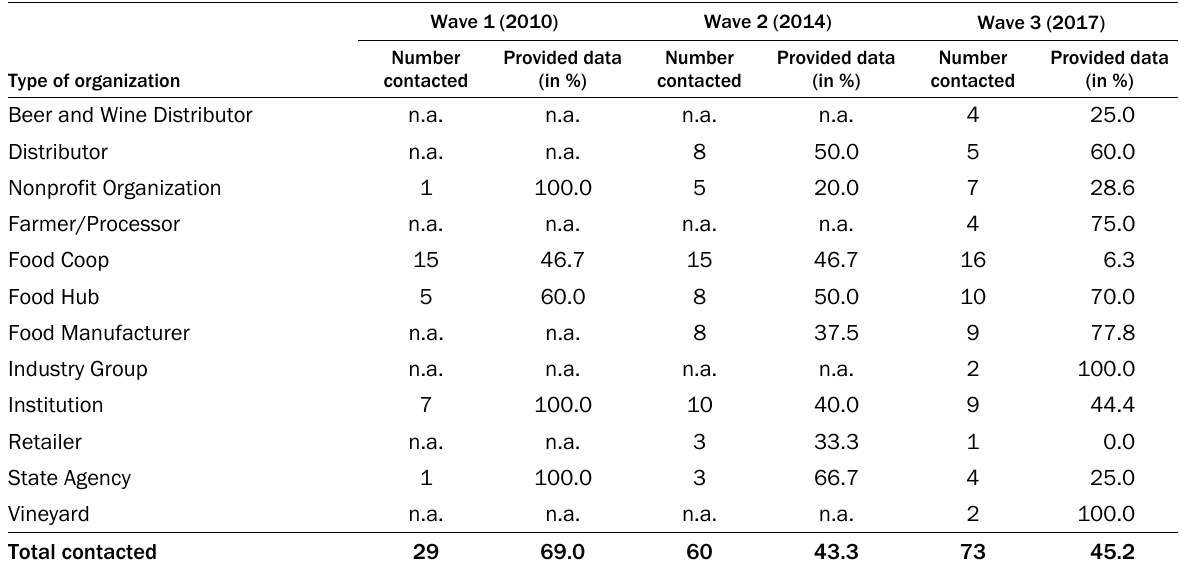
Table 1. Number of Organizations Contacted and Percent that Provided Data by